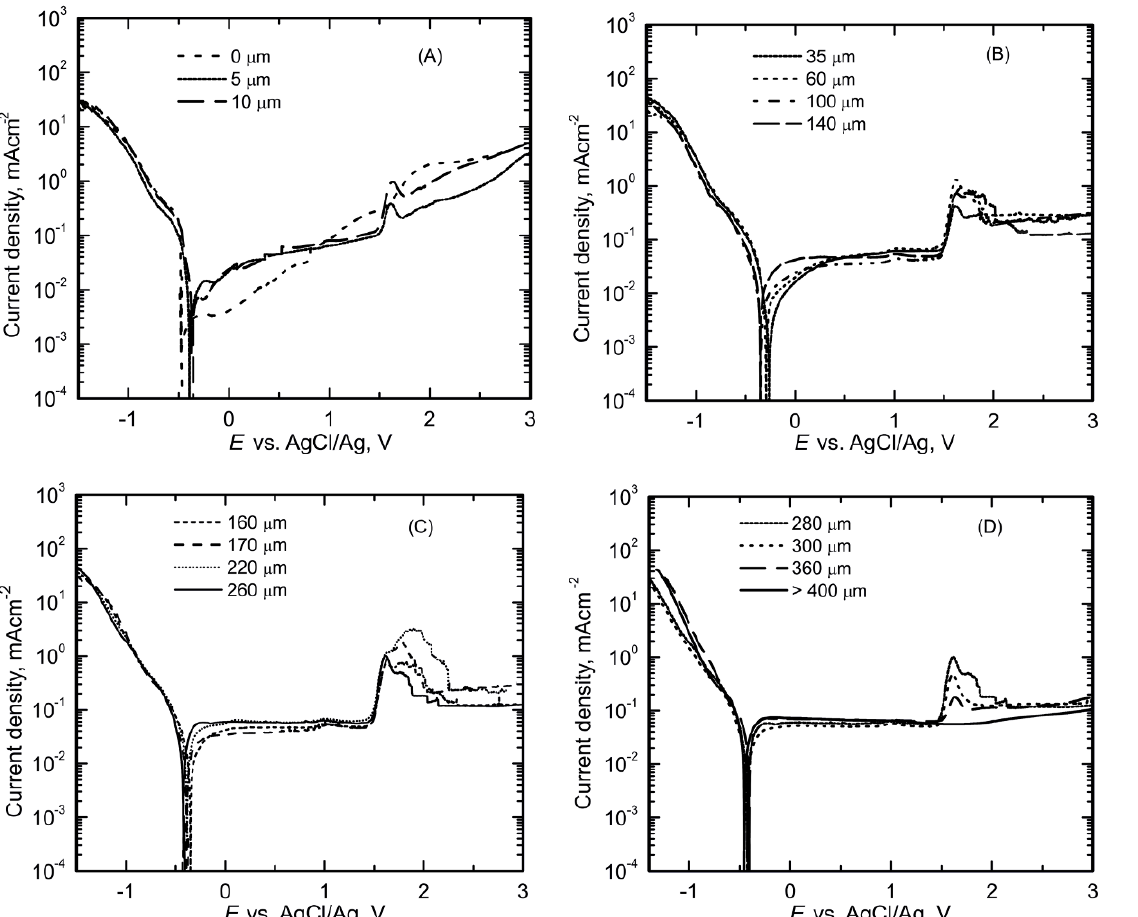
Figure 2. Potentiodynamic polarization curves of glow-discharge nitrided Ti-1Al-1Mn titanium alloy at different depths: (A) external nitrided layer with